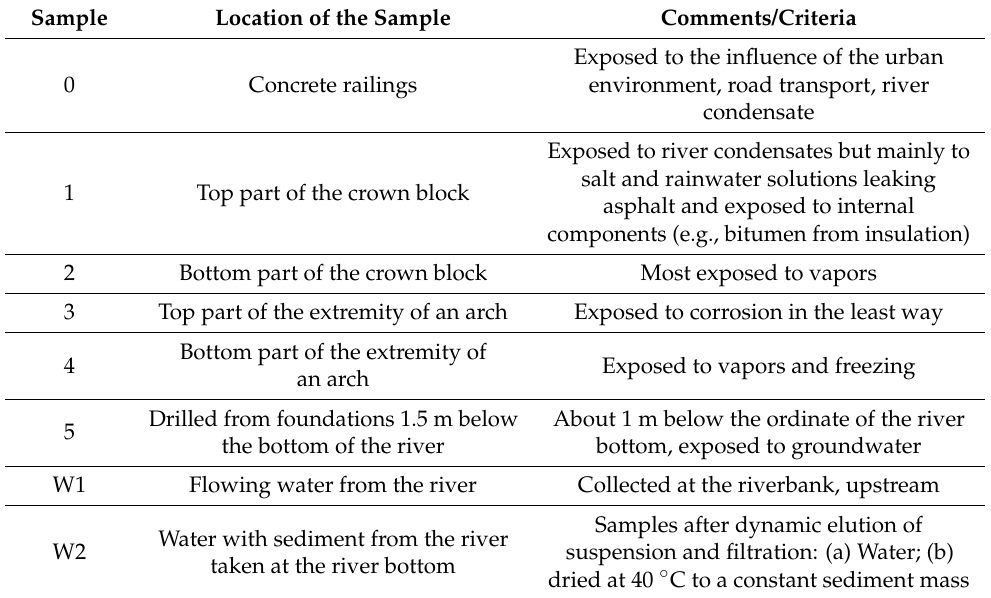
Table 4. Characterization of